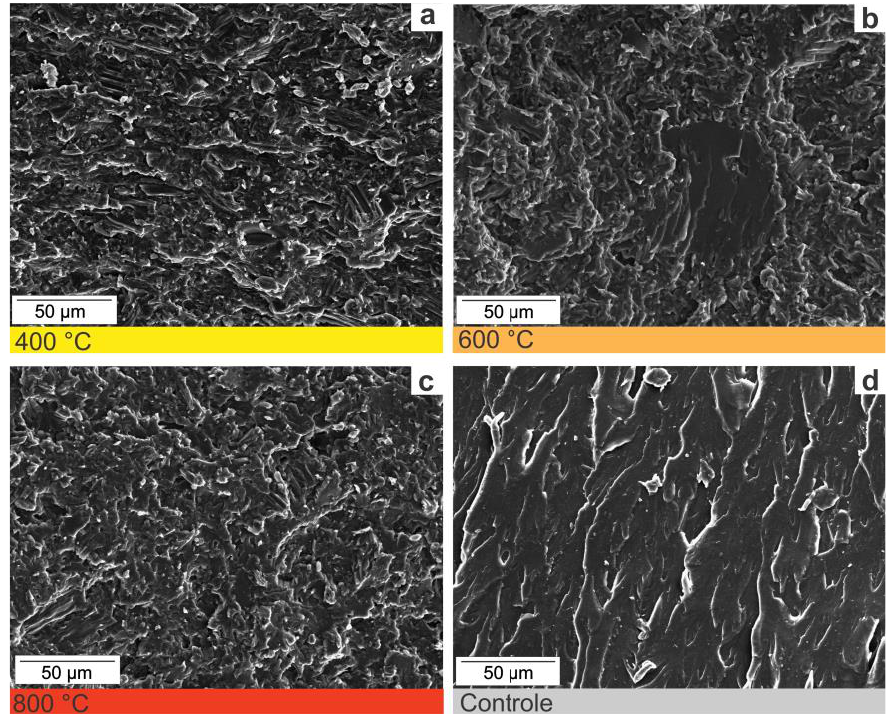
Figure 9. Micrographs obtained by scanning electron microscopy of biocomposites produced with charcoal fine samples synthesized at 400 ( a ), 600 ( b ), 800 °C ( c ), and control ( d ) in ×300 magnification .